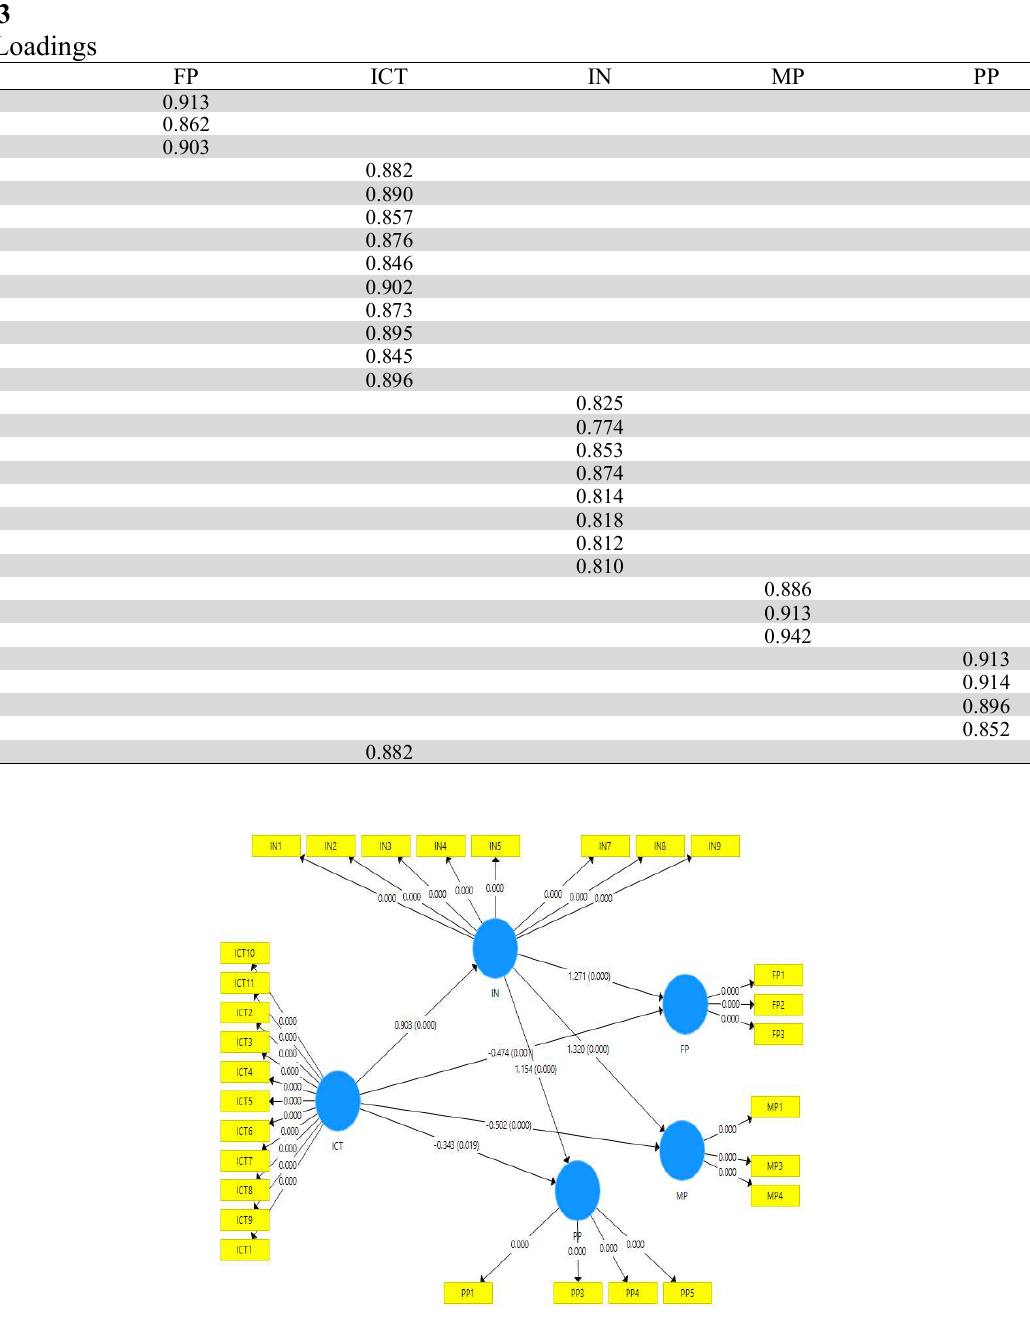
Fig. 3. Structural